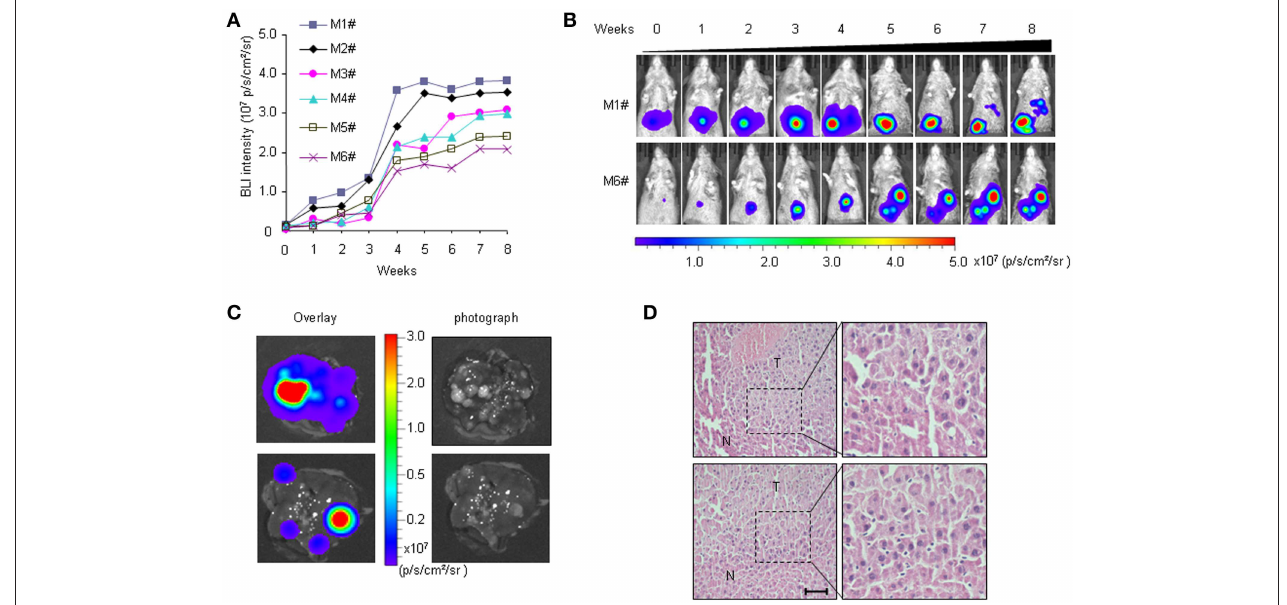
FIGURE 1 | Non-invasive visualization of HCC progression in HCR mice via BLI. (A) in vivo quantified serial BLI intensity in each mouse for 8 weeks (M1# to M6# represent six mice monitored). (B) Serial bioluminescence imaging of liver cancer in representative HCR mice according to the time course [M1# and M6# represent the mice from (A) ]. (C) Ex vivo BLI intensity and the presence of tumor nodules after 4 weeks of BLI monitoring. The photograph shows multiple visible liver tumors upon autopsy (right), most of which were luc-positive based on ex vivo BLI (left). (D) Histological analysis of liver samples from HCR mice after 4 weeks of BLI monitoring. Liver cancer nodules bearing strong BLI intensity (1.0–5.0 × 10 7 p/s/cm ² /sr) were stained with hematoxylin/eosin (H&E). Scale bar: 20 µ m.